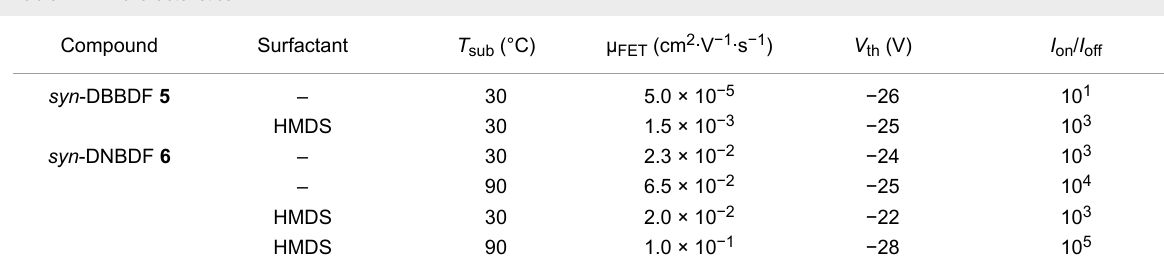
Table 2: FET characteristics.